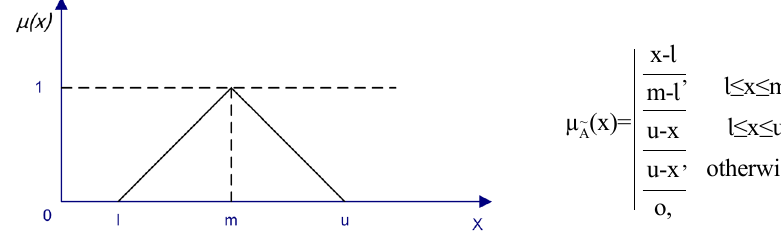
Figure 1. Fuzzy triangular